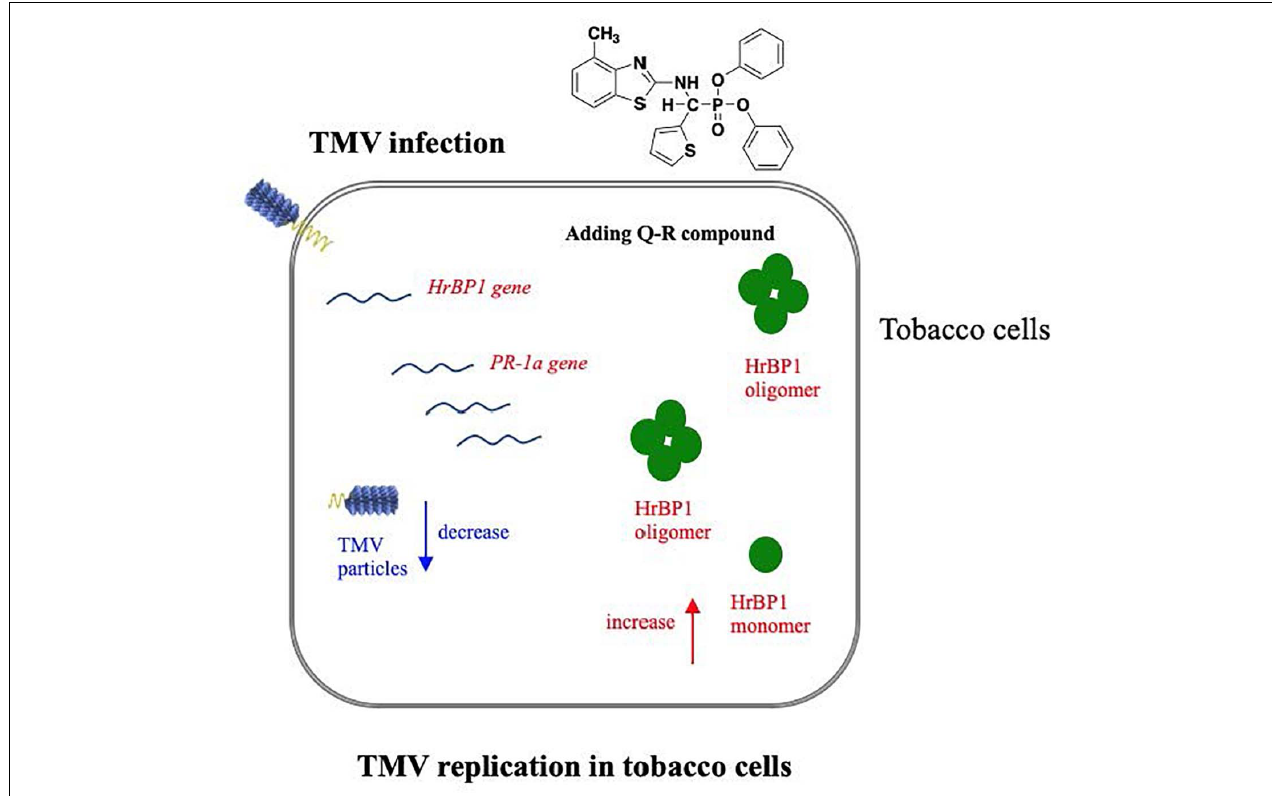
FIGURE 6 | Hypothetical pathway wherein the HrBP1 protein of tobacco plant was induced by Q-R through promotes the expression of the HrBP1 and PR-1a genes in tobacco plants, which leads to Q-R induces antiviral responses and inhibits the duplication of TMV in TMV-infected tobacco plant. Red indicate the up-regulated genes/protein, blue indicate the down-regulated